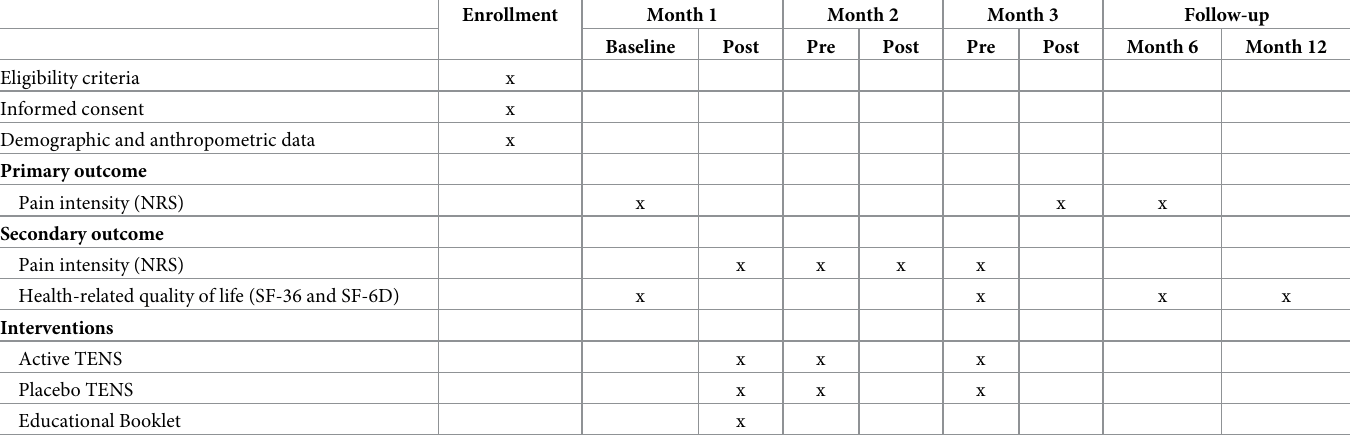
Table 1. Timeline for the schedule of enrollment, assessments, and